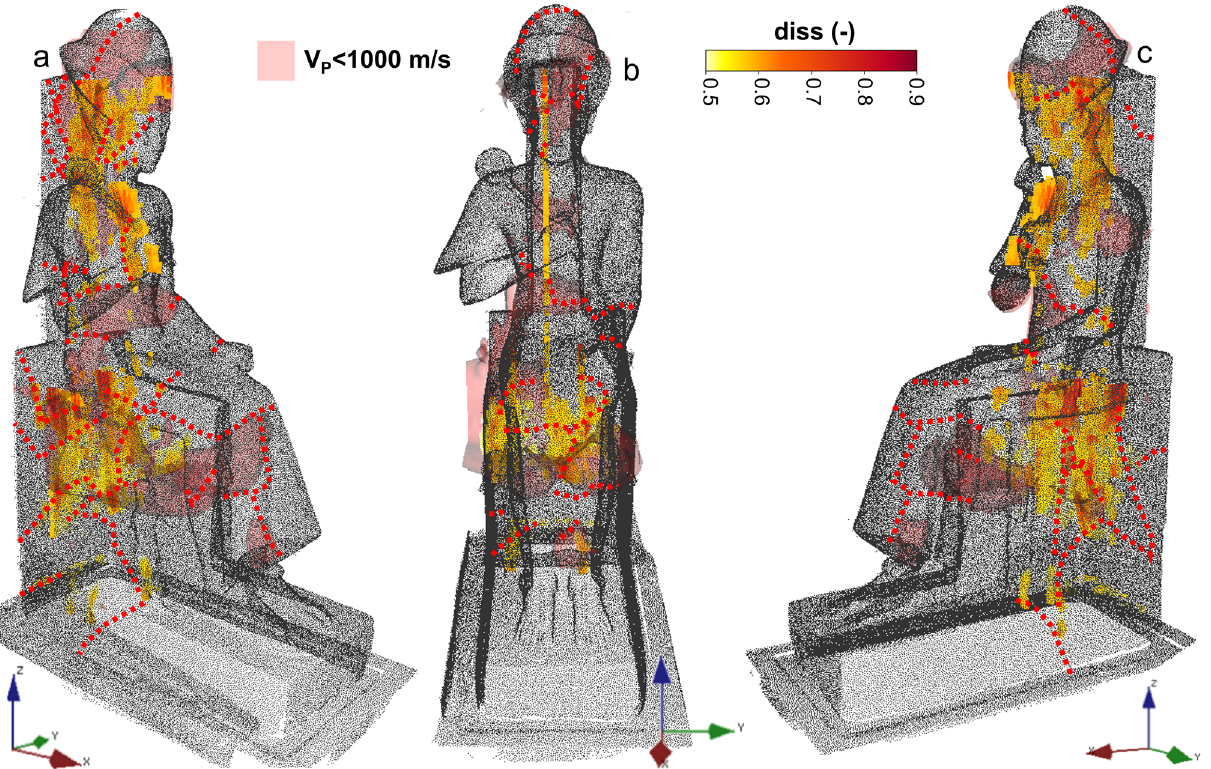
Figure 7. 3D comparison between local dissimilarity anomalies and isosurfaces with ultrasonic velocity lower than 1000 m/s: ( a ) right side, ( b ) front view, ( c ) left side of the statue. The main superficial fracture traces are highlighted by red dotted lines. Figure created in Voxler (Demo version 4.6.913, https:// www. golde nsoft ware. com/ produ cts/ voxler).